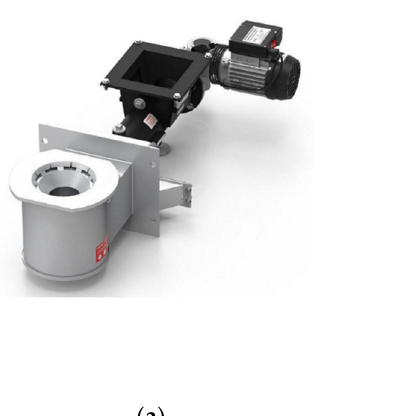
Figure 3. Gasification of biomass fuel in the retort burner: (1)—syngas chamber, (2)—gasification furnace, (3)—air chamber, (4)—gasification air inlets, (5)—combustion air inlets, (6)—screw feeder, (7)—air blower, (8)—syngas purification battery, (9) measurement of syngas composition—GAS 3000 syngas analyser. Table 2. Syngas components from biomass.